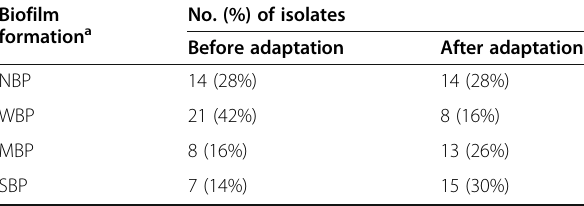
Table 1 Biofilm formation by K. pneumoniae isolates before and after BAC adaptation Biofilm formation